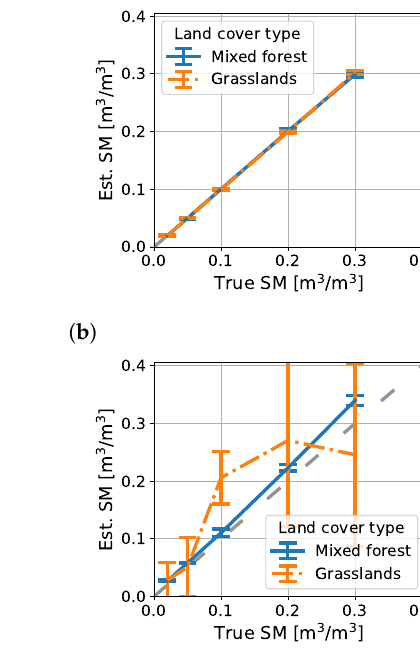
Figure 7. Soil moisture retrievals from simulated DDM, for grassland land cover using the first scheme. The error bars represent one standard deviation from the mean, and the gray lines represent perfect retrievals. ( a ) σ h = 0.5cm, θ SP = 20°, SNR = 10dB. ( d ) θ SP i